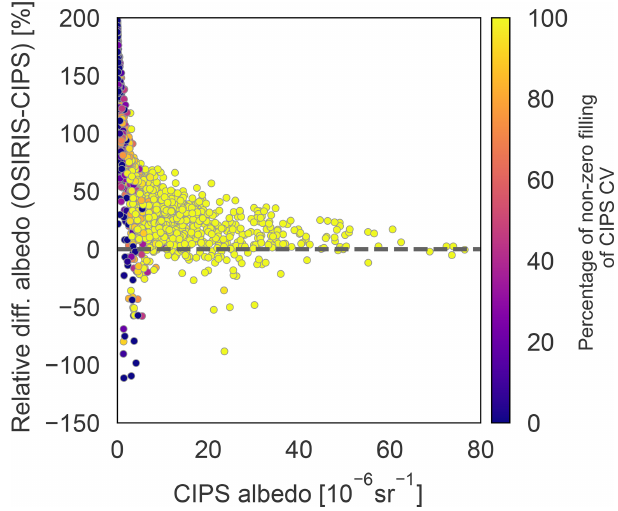
Figure 5. Relative difference in cloud albedo in CV ele- ments (2 × (OSIRIS-CIPS) / (CIPS + OSIRIS)) vs. CIPS albedo. The points are colour-coded by the percentage of filling of non-zero pixels in a CIPS CV element.